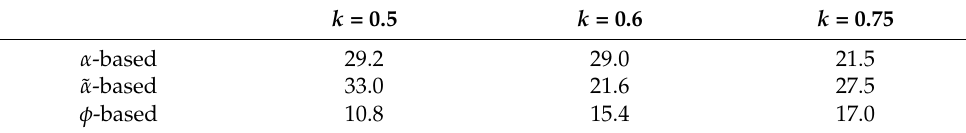
Table 5. Percentage error, (cid:101) r ( k ) , in satellite droplet size predictions. k = 0.5 k =